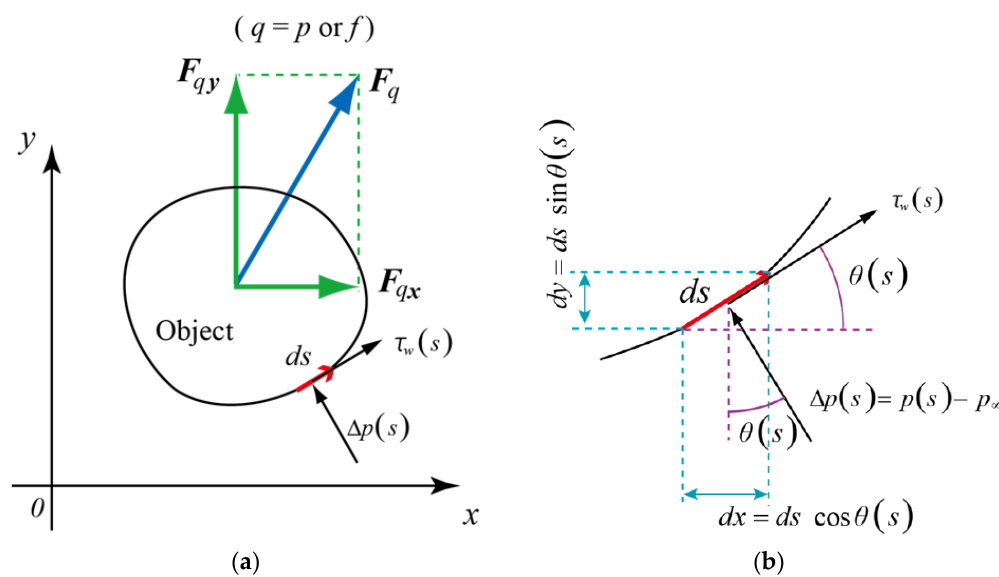
Figure 10. Schematic drawings for calculation of the resultant forces that act on an arbitrary two-dimensional (2D) body by integrating the surface pressure or the wall shear stress (surface friction): ( a ) description of the 2D object and coordinates and ( b ) enlarged view of a portion of the surface, and the definition of angle of θ .